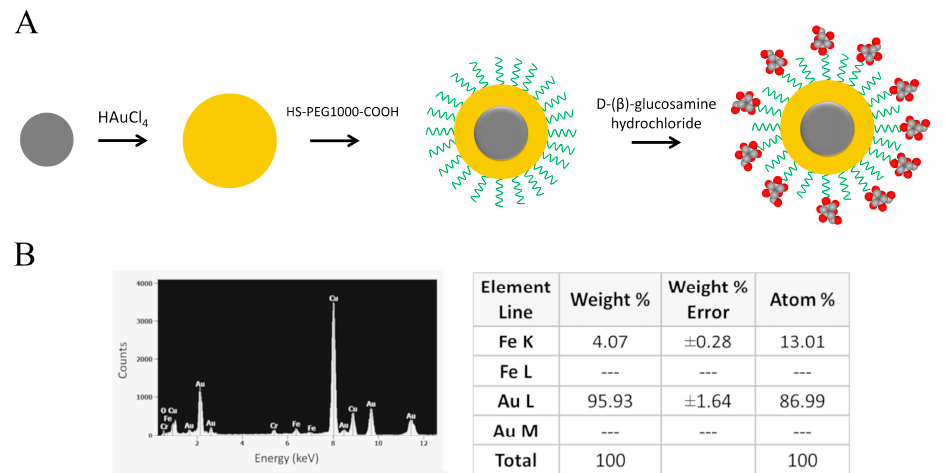
Figure 1. Nanoparticle characterization. ( A ) Scheme of glucose-coated Fe 2 O 4 @Au nanoparticles. Iron oxide nanoparticles were coated with a gold shell and then with a PEG1000 linker for subsequent glucose conjugation; ( B ) EDAX spectrum profile showed absorption peaks for Au and Fe in Fe 2 O 4 @Au particles (left), and quantification of the EDAX results is shown (table, right). UV-vis spectra showed a surface plasmon resonance peak at 522 nm. EDAX analysis